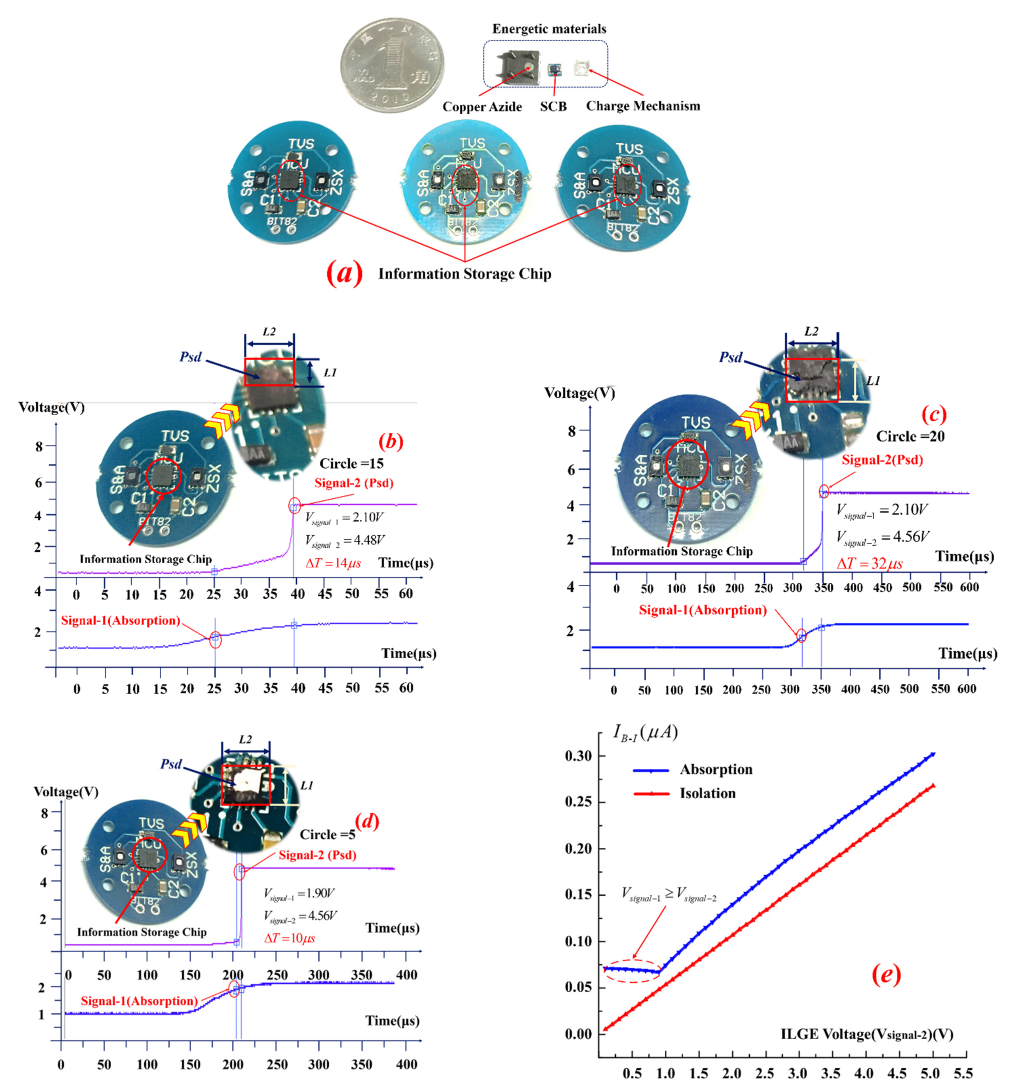
Figure 9. ( a ) ISC P sd module, ( b – d ) Psd times for different numbers of test cycles, and ( e ) leakage currents between the BLGE and the ILGE under the absorption/isolation states. currents between the BLGE and the ILGE under the absorption/isolation